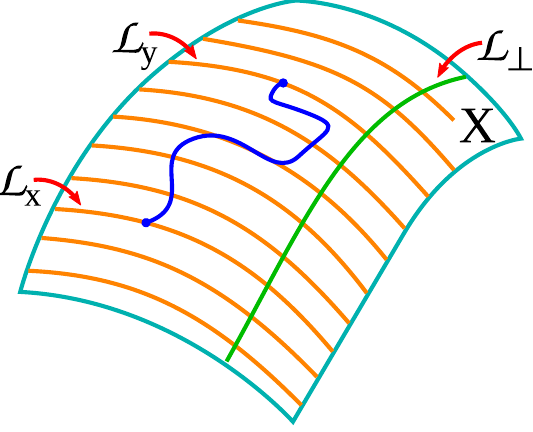
Figure 2 . Orange curves represent foliation of X by Lagrangian submanifolds corresponding to a given real polarization P . Blue curve is a trajectory starting at L x and ending at L y ; we integrate over such trajectories. Green curve represents a Lagrangian submanifold L ? that is transverse to the polarization; it might be convenient to think of physical states written in polarization P as half-densities on L ?